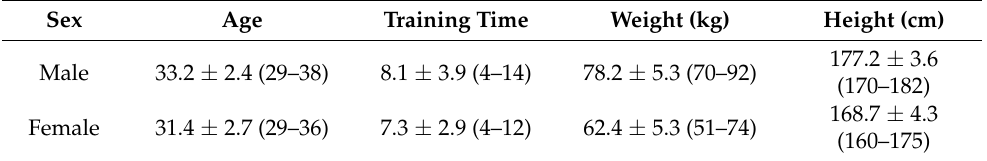
Table 1. Canoe polo athletes’ anthropometric characteristics. Mean ± s